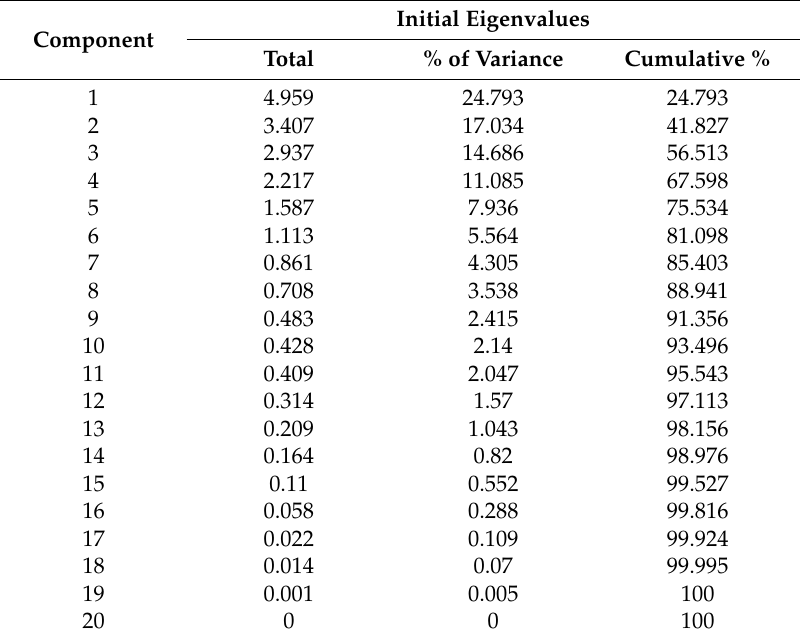
Table 2. Contribution of the principal components to the total variance.